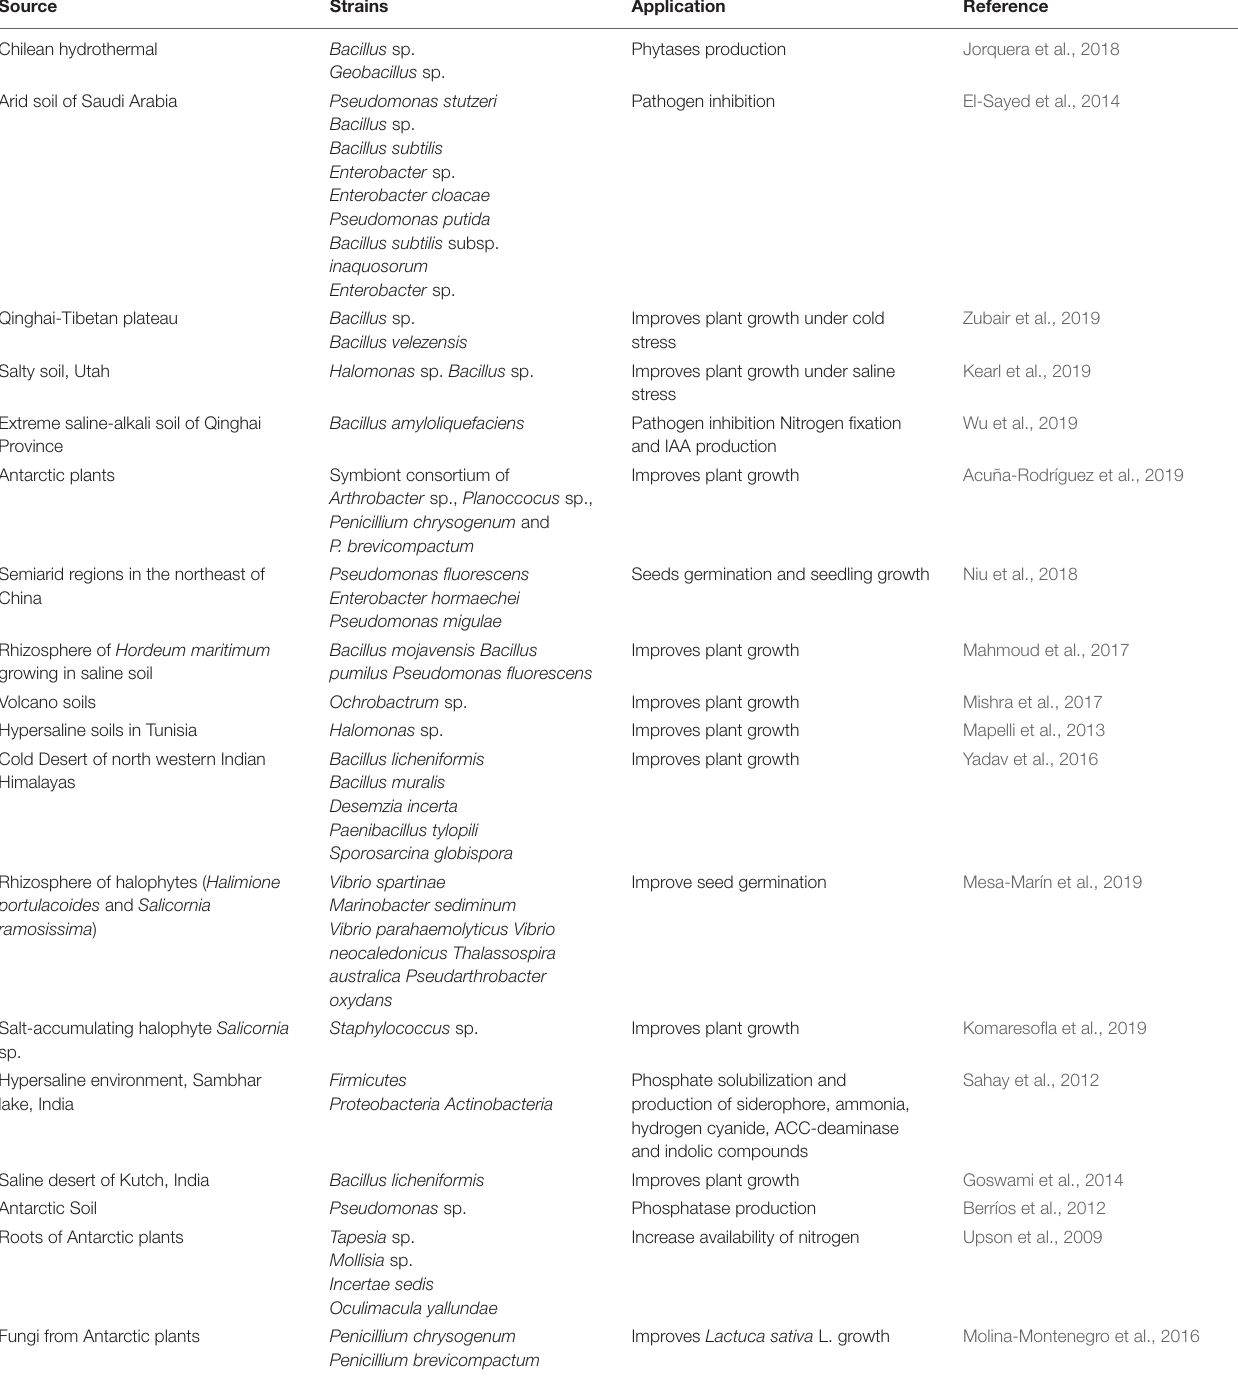
TABLE 1 | Plant Growth Promoting Microorganisms isolated from extreme environment to improve crop